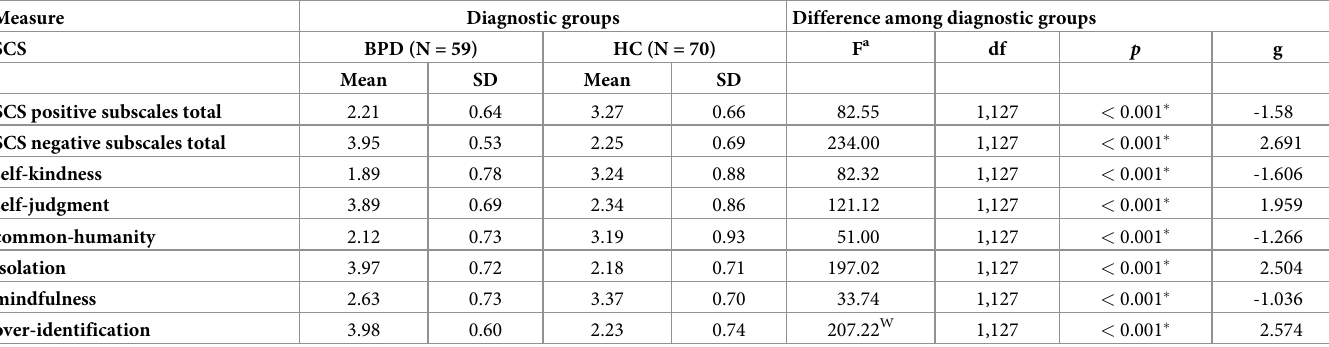
Table 7. Group comparisons of the BPD and HC groups on the subscale scores of the self-compassion scale, and effect sizes measured by Hedge’s g formula.